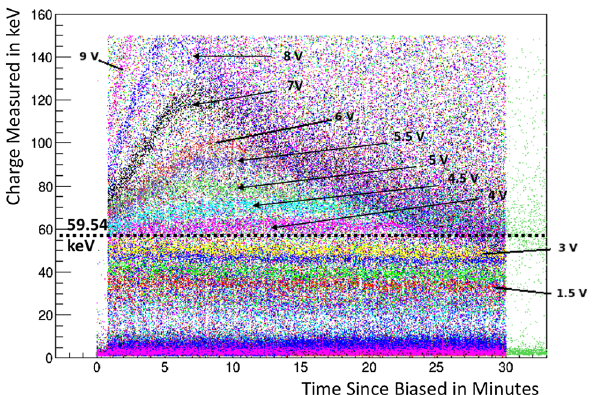
Fig. 4 Shown is the time-dependent charge response from Q4 at posi- tive biases for Run 67. The baseline of 59.54 keV gamma ray from Q4 initially rose linearly for a few minutes, then quickly transitioned to an ∼ exponential fall off over 10s of minutes